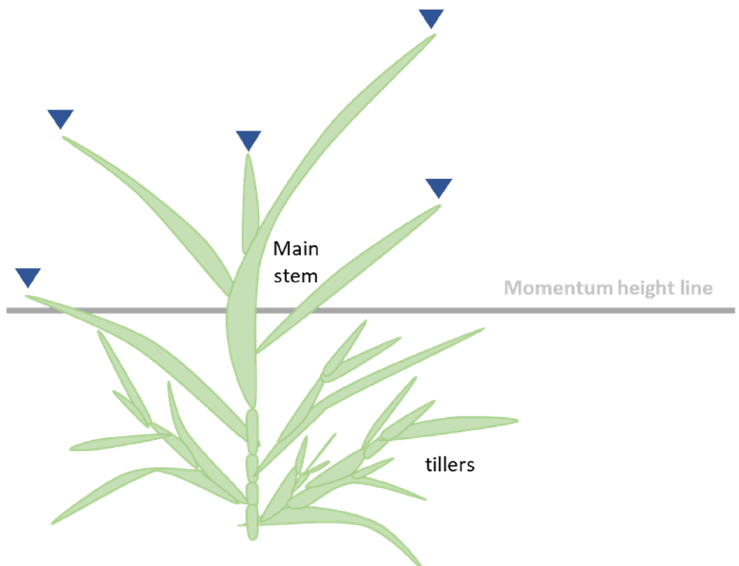
Figure 3. Phenotyping approach. Only the leaf tips above the momentum height (indicated by Inverted triangle) were counted.